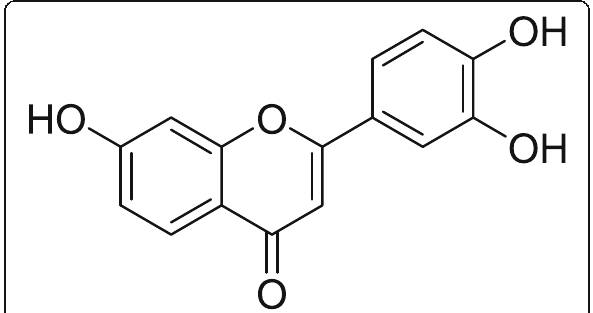
Fig. 1 Chemical structure of 3 ′ ,4 ′ ,7-trihydroxyflavone isolated from the seeds of Myristica fragrans